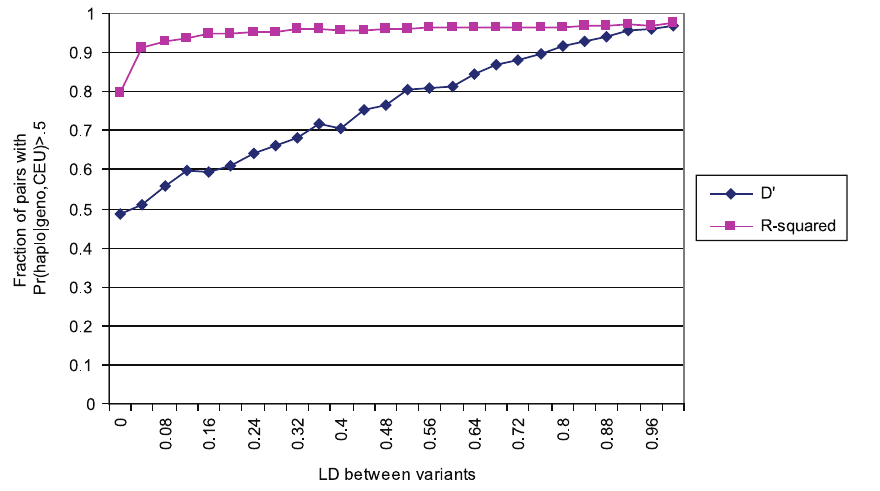
Figure 13. Consistency of HuRef Haplotypes with HapMap Data Haplotypes inferred from the HuRef data are strongly consistent with HapMap haplotypes. The probability in the HapMap CEU panel of the observed genotypes being phased as per the HuRef haplotypes is high for variants in strong LD (as measured either by D 9 or r 2 ) .